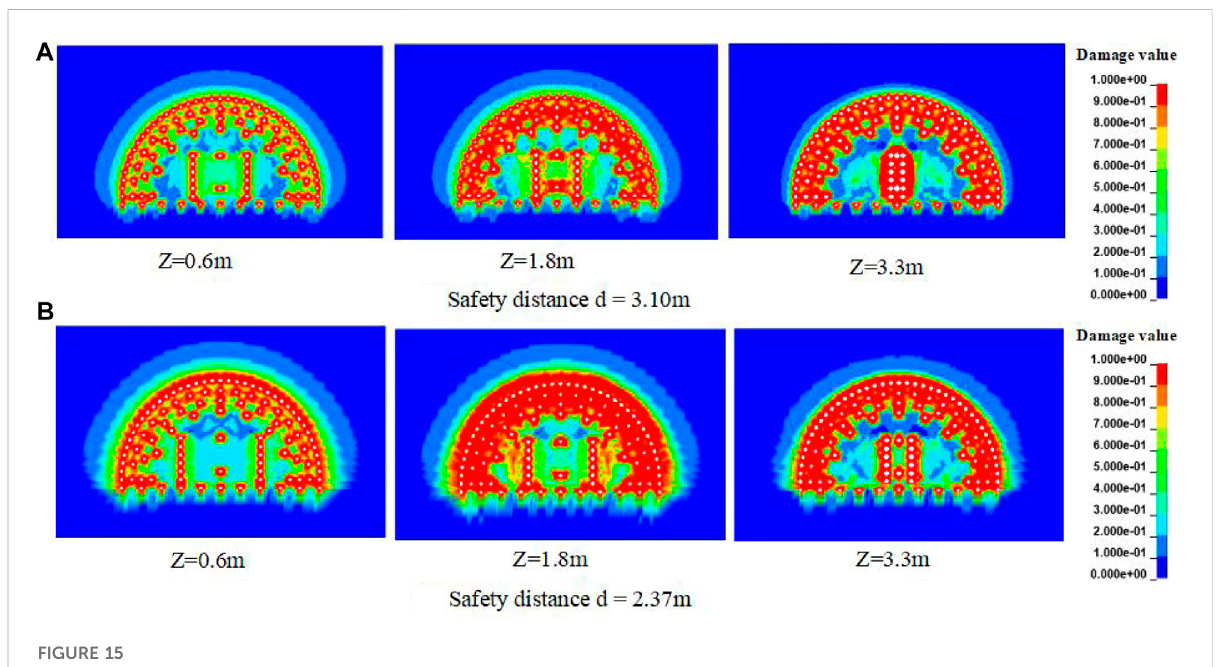
FIGURE 15 Damage cloud images of different safety